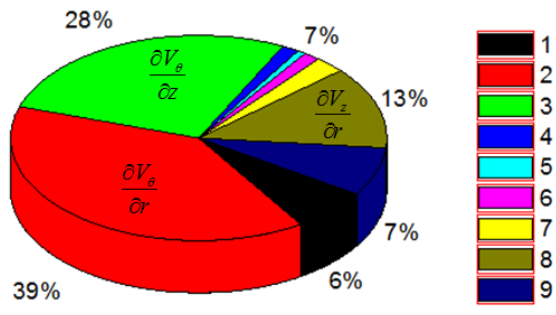
Figure 14. Proportion of velocity gradient based on mass flow integral, IR = 1.5%.